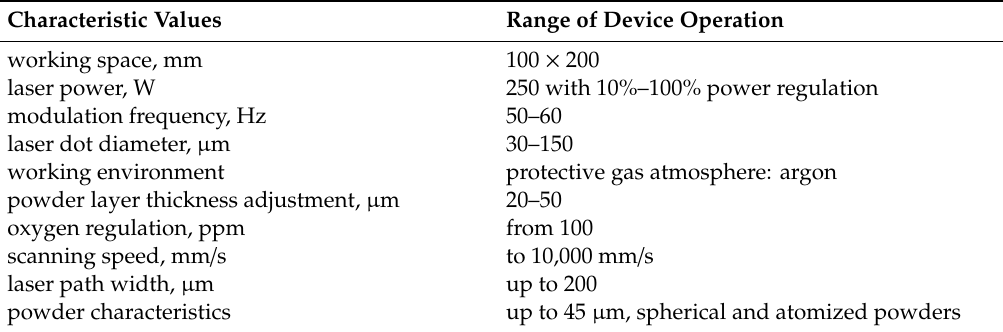
Table 2. Operation characteristics of the Orleas Creator device.